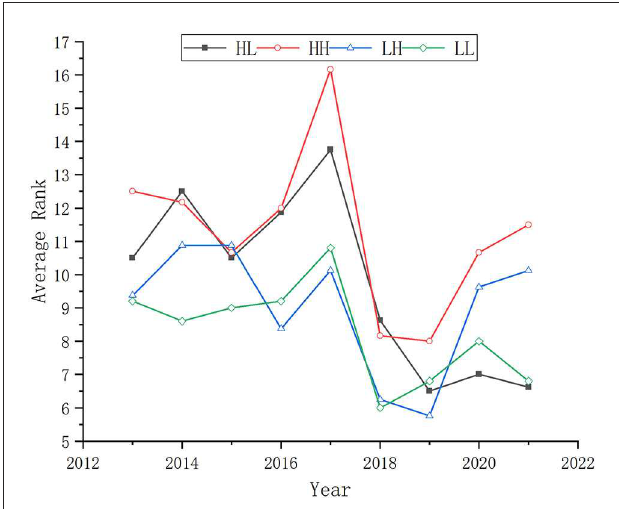
FIGURE3 Variation of the average rank of ESI efficiency score in different zones.